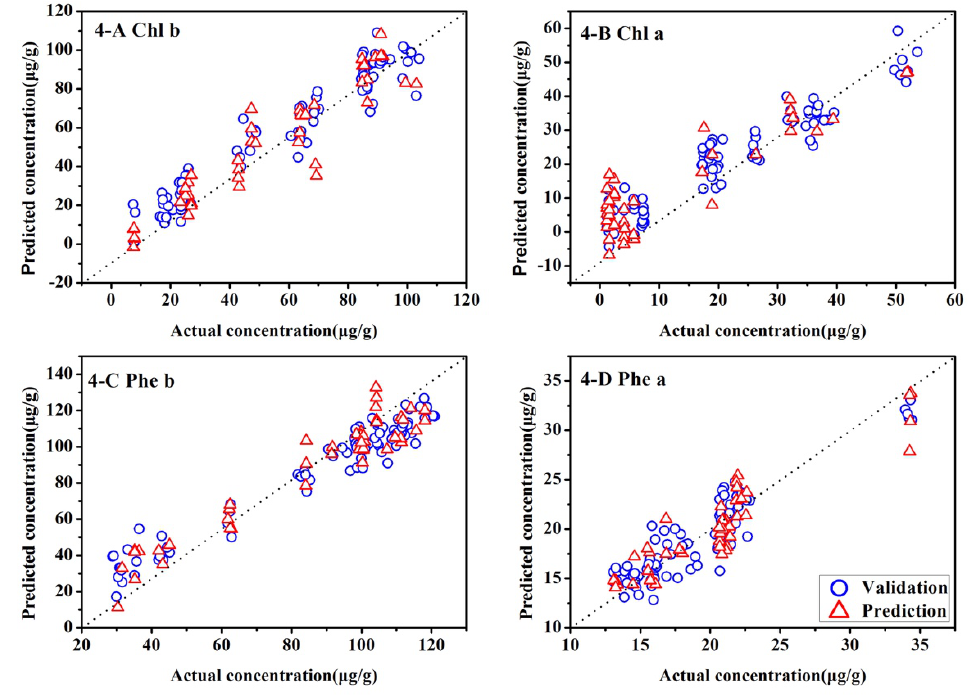
Figure 5. Scatter plots of measured vs. predicted concentrations of the LS-SVM, ( A ) Model 4-A of Chl-b; ( B ) Model 4-B of Chl-a; ( C ) Model 4-C of Phe-b; ( D ) Model 4-D of